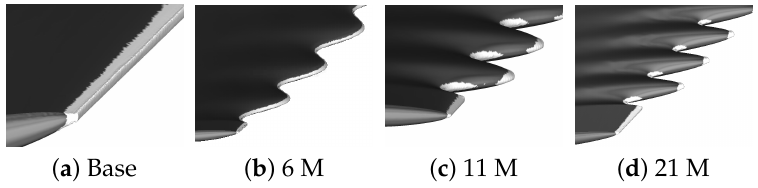
Figure 9. Changes in ice accumulation at the leading edge of different wavelengths. Based on the change of lift coefficient and maximum lift-to-drag ratio, the present study analyzes the aerodynamic changes of protrusions with different amplitudes and wavelengths before and after ice accumulation. The influence mechanism and specific changes in ice type at the leading edge are not clearly